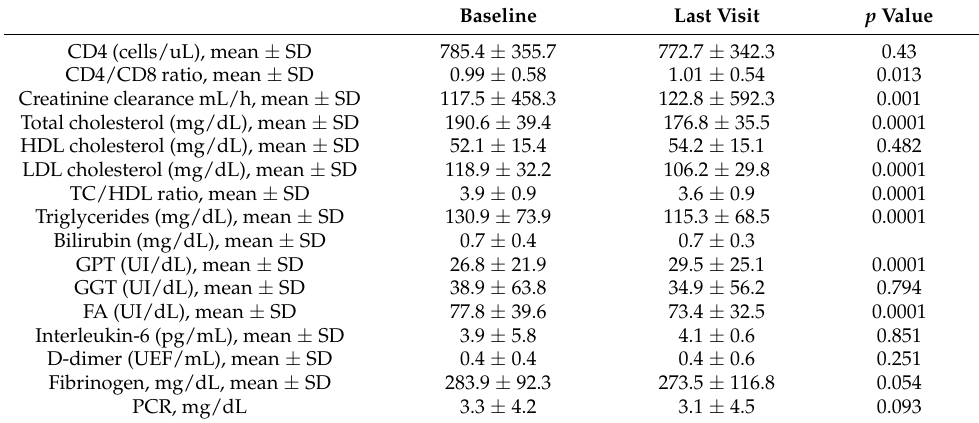
Table 4. Analytical changes between baseline visit and last